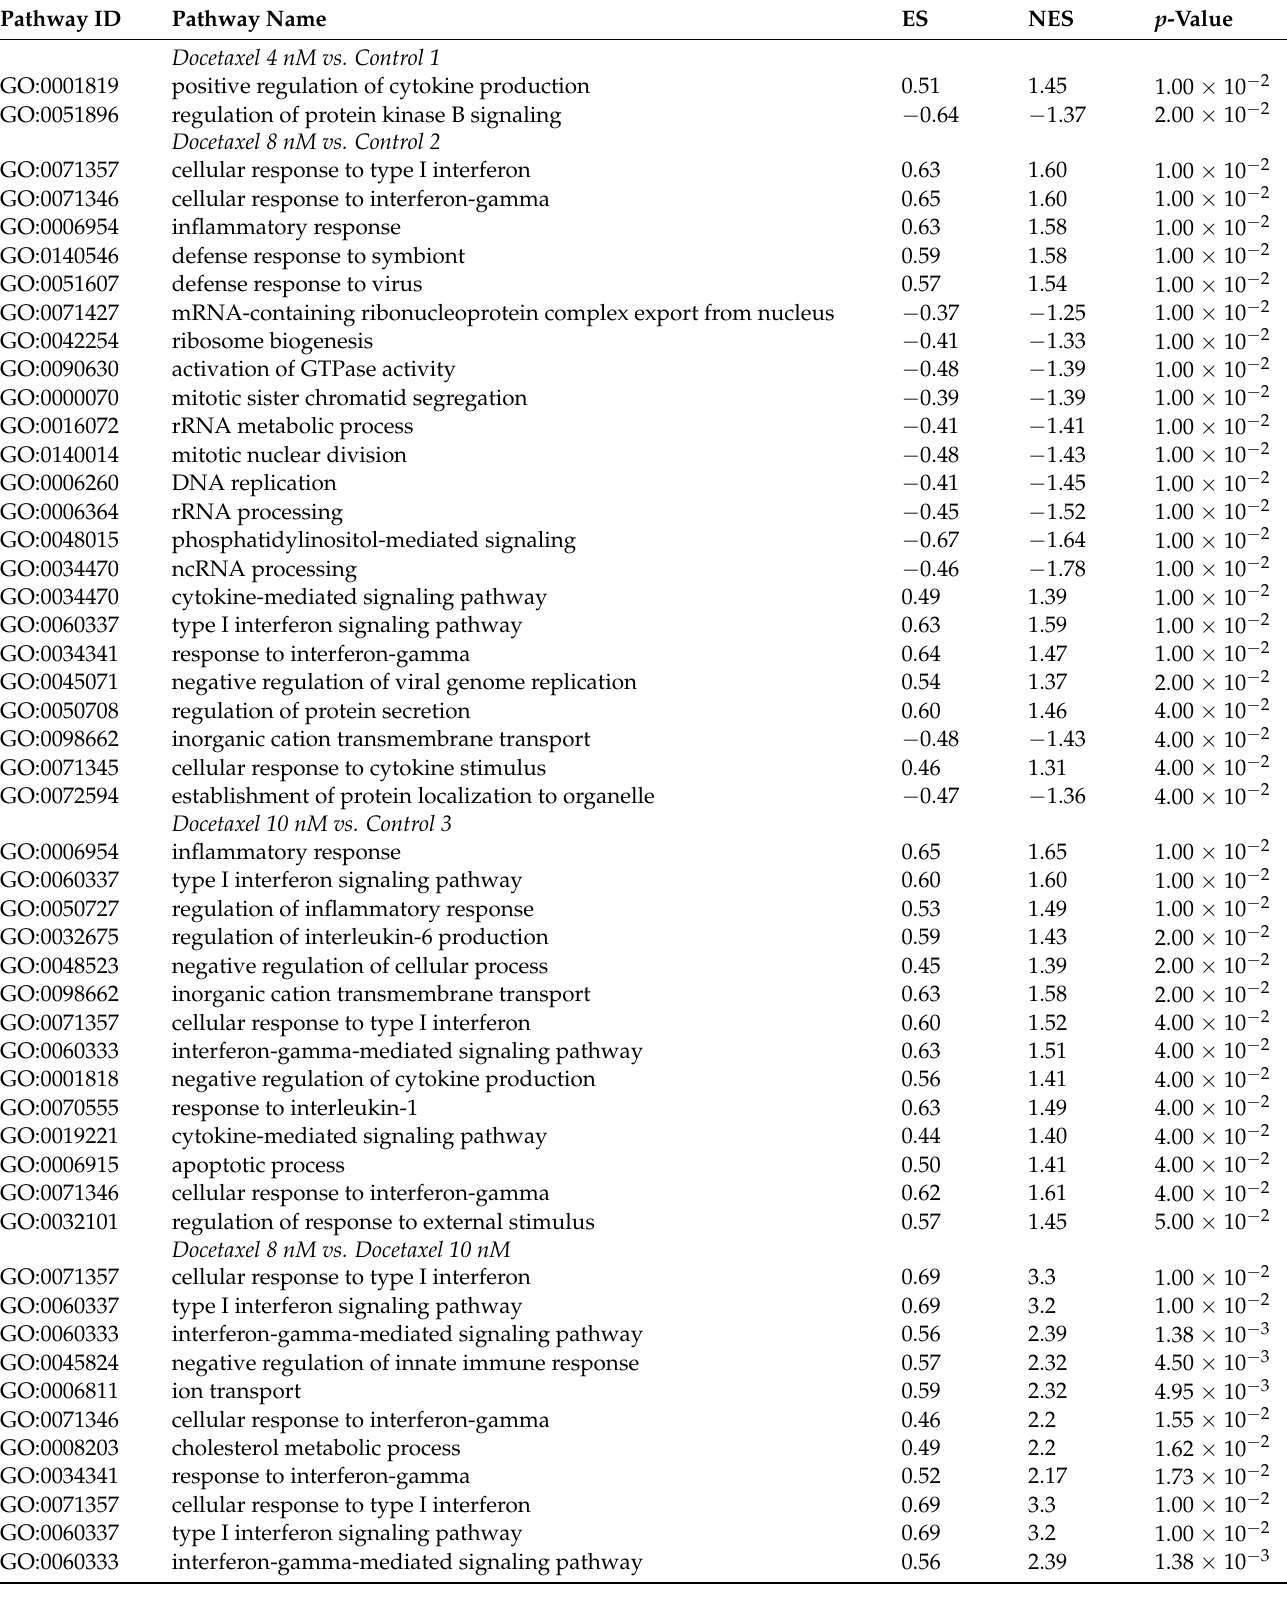
Table 1. List of statistically significant pathways associated with different periods of PC3 cells docetaxel treatment, according to the Gene Ontology Biological Process 2021